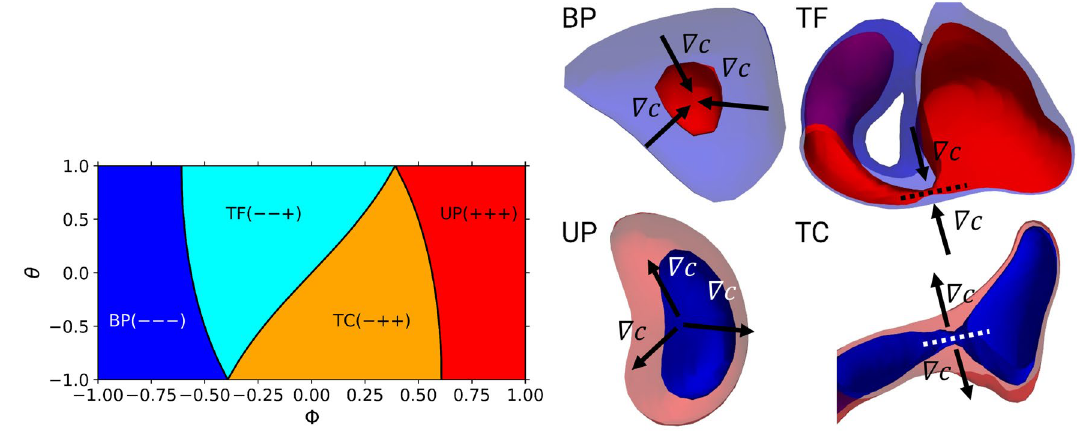
Figure 3. Topology types of the FSI (left) as characterized by the shape factors (burned pocket: BP, unburned pocket: UP, tunnel formation: TF, tunnel closure: TC). The black boundary lines between the colored areas denote sign changes in an eigenvalue of H ( c ) . Examples of FSI topologies (right), with blue isosurfaces denoting low values of c and red isosurfaces denoting high values of c (the enveloping isosurfaces are semitransparent). In addition, the gradient direction of c is shown schematically. The examples are taken from the lean case after the